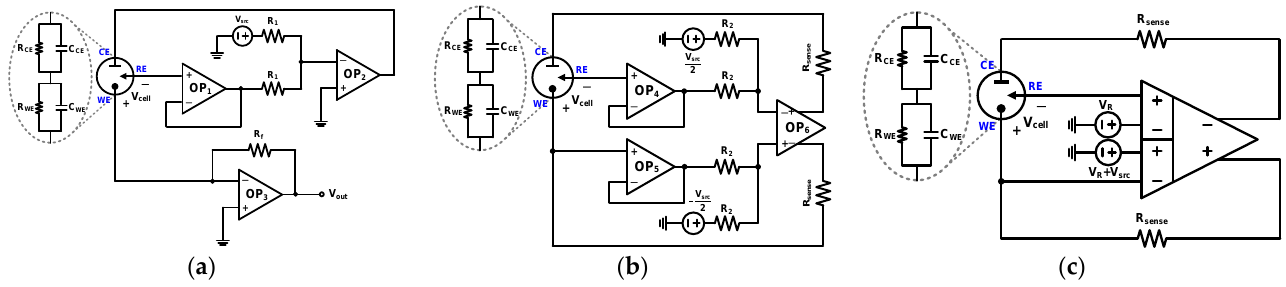
Figure 2. ( a ) Single-end topology, ( b ) fully differential topology, and ( c ) fully differential difference topology.